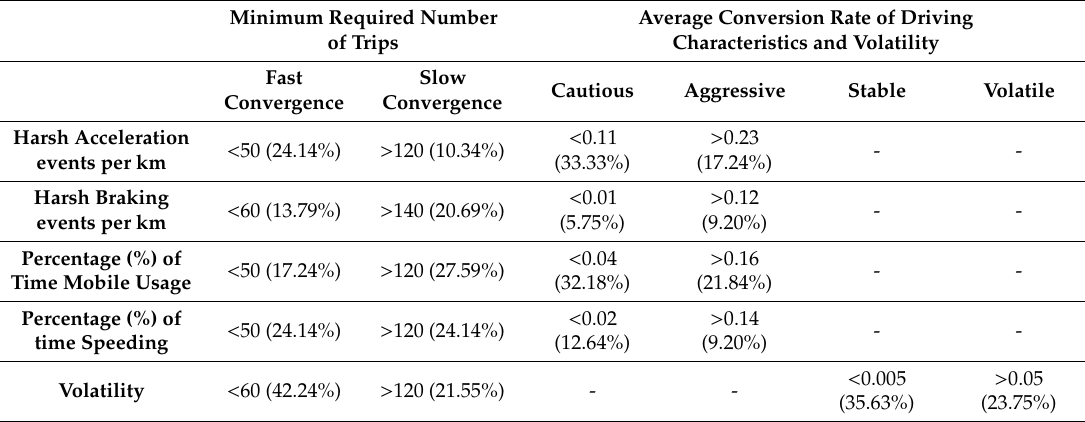
Table 2. Aggressiveness, volatility limits and convergence rate of driving